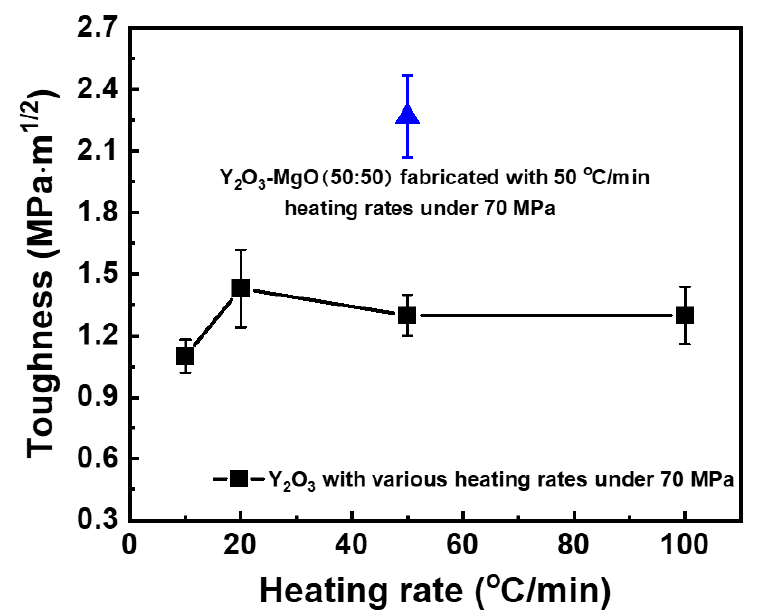
Figure 12. The fracture toughness K IC plotted as a function of the heating rate. For comparison, K IC of the Y 2 O 3 -MgO nanocomposites reported in our previous work (triangle) [34] is also given.